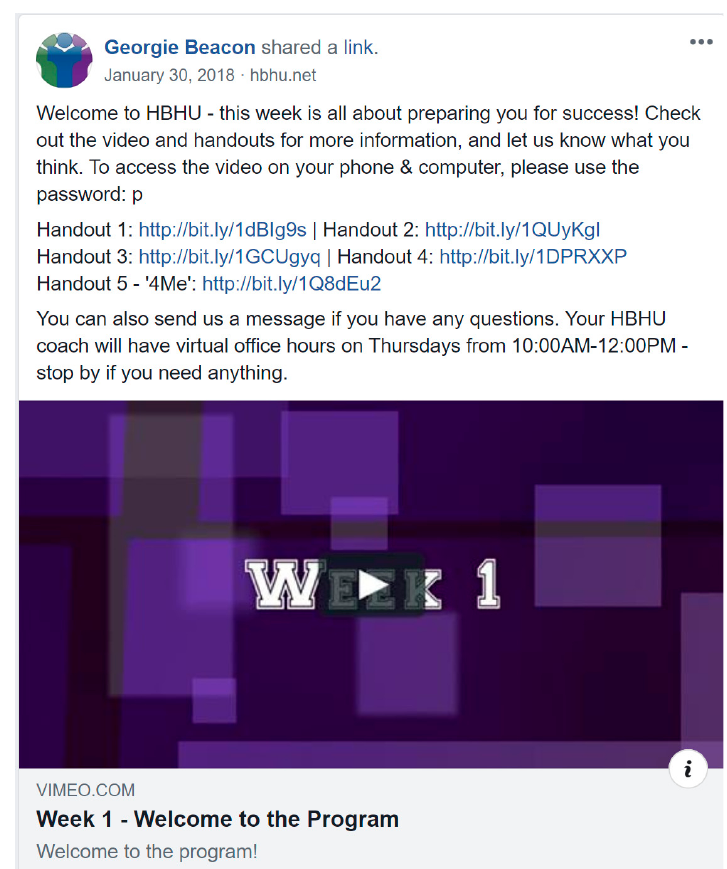
Figure 2. Sample w eekly didactic lesson post by the study team (“Wk1_Tu” in Table 2). Figure 2. Sample weekly didactic lesson post by the study team (“Wk1_Tu” in Table 2). Receiver : This variable, meant to measure the audience of the message, has been Table 2. Coded date for all posts (n = 32). divided into three demographic variables in order to quantify the profile of an engaged receiver. Demographic data for each study participant that engaged with a post was aggre- gated and an average was calculated for each post for the following demographic variables: age, sex, and BMI. Age and sex were collected from each participant at baseline. BMI was calculated from height and weight (kg/m 2 ) measured at baseline. A BMI of 25–29.9 kg/m 2 is in the overweight category. A BMI of 30 or greater is in the obesity